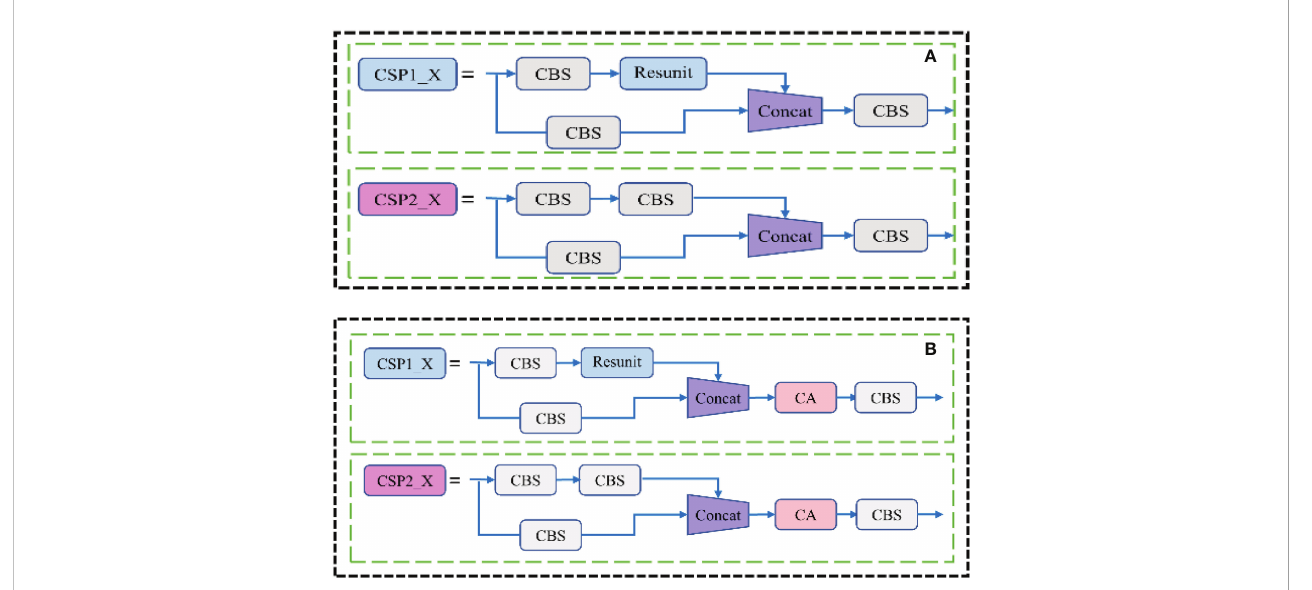
FIGURE 6 Model comparison before and after the CA module was embedded in the CSP structure (A) Before improvement; (B) After